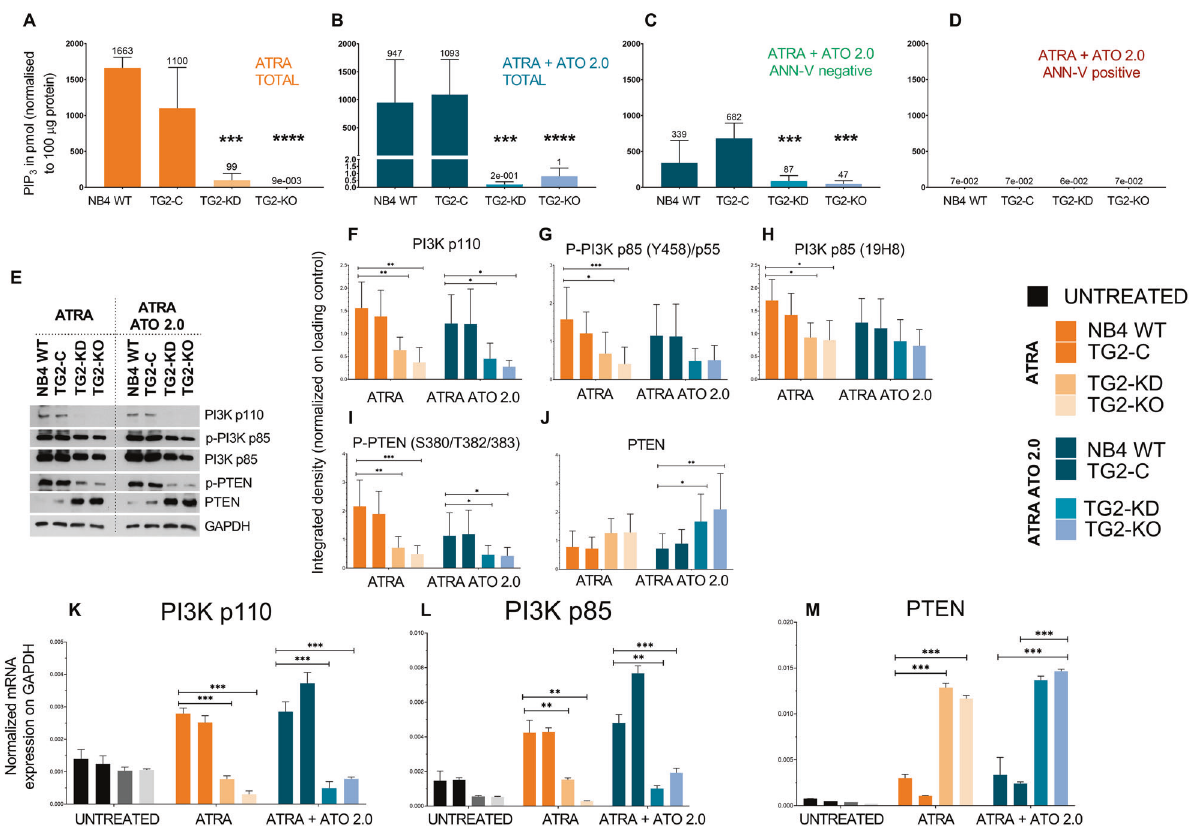
Fig. 4 TG2 is required for enhanced PI3K-AKT-mTOR signal transduction pathway activity. A – D Membrane PIP 3 levels were quanti fi ed by an ELISA-based fl uorescence detection method (Echelon Inc.). Figures show the representation of the mean values ±SD of PIP 3 levels from three independent experiments ( n = 3). Measurements were conducted in triplicate. A PIP 3 levels in ATRA-treated total NB4 cells. B PIP 3 levels in ATRA + ATO treated unsorted NB4 cells. C PIP 3 levels in ATRA + ATO-treated Annexin-V labelled but Annexin-V negative cells. D PIP 3 levels in ATRA + ATO-treated Annexin-V labelled and Annexin-V positive cells ( n = 3). E Representative western blot showing PI3K subunits, p-PTEN, PTEN, and GAPDH protein expression levels in NB4 cells treated for 5 days with ATRA or ATRA + ATO ( n = 5). F – J Densitometry analysis of western blots of PI3K pathway proteins. K – M Relative mRNA expression of PI3K - p110, PI3K-p85 , and PTEN in NB4 cells treated with 1 μ M ATRA or 1 μ M ATRA + ATO; RT-qPCR results are normalised to GAPDH ( n = 3). Statistical analysis was conducted by two-way ANOVA (Bonferroni post hoc test; * p < 0.05, ** p < 0.01 and *** p < 0.001, **** p < c-SRC, phosphorylated mTOR (S2481, S2448) from mTORC1 and mTORC2, phospho-AKT (S473, T308), PI3K/p110 and PI3K phospho-p85 (Fig. 5D, 1st and 2nd vertical panel). At the same time, antibodies to mTOR, AKT, CD18, p85, PI3K/p110, PTEN, and c-SRC also co-immunoprecipitated with TG2 in the reciprocal co- immunoprecipitation experiments (Fig. 5D, 1st and 2nd horizontal panel). Treatment for 5 days with either the NC9, TG2 inhibitor or the PP2, c-SRC inhibitor abolished all interactions between TG2